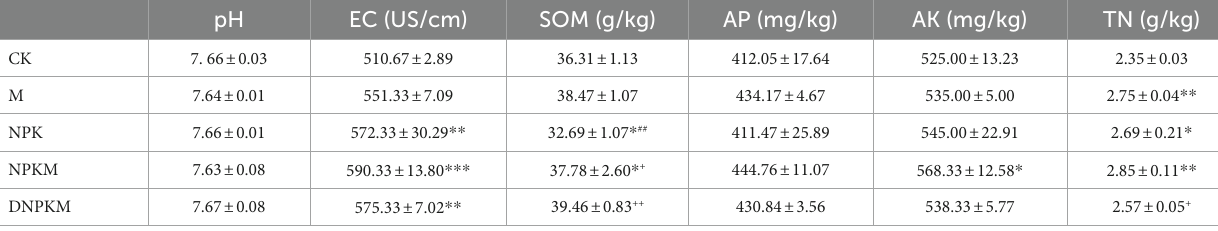
TABLE 1 Soil physicochemical properties of different fertilizer treatments.